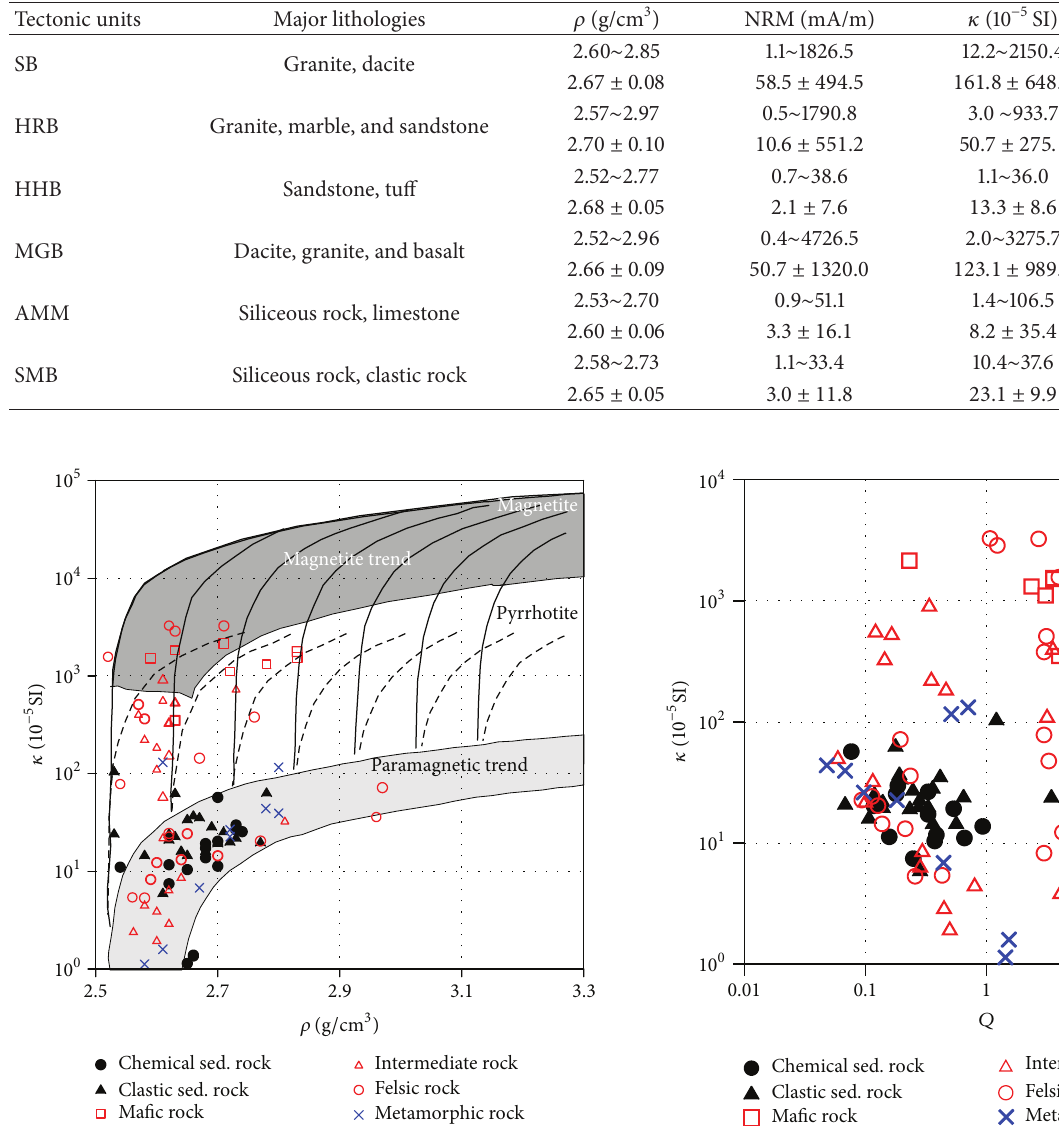
Figure 7: Bivariate distribution of density (𝜌) versus magnetic susceptibility (𝜅) for all samples sorted for major lithologies.